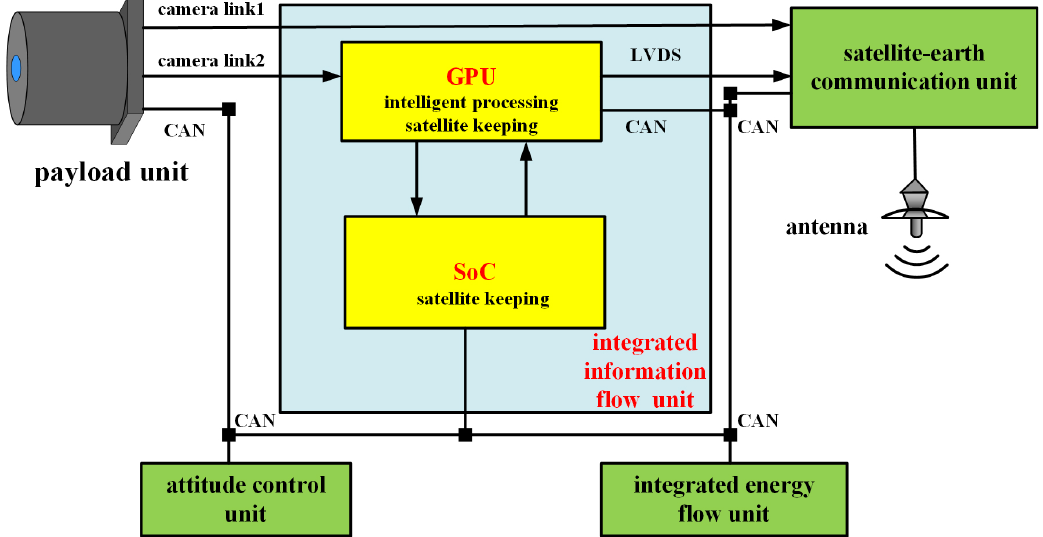
Figure 5. Hardware architecture of the integrated information